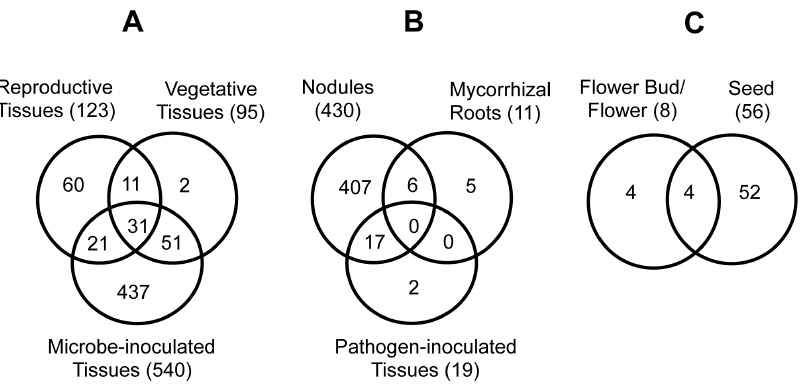
Figure 8. Venn diagrams of Medicago DEFL s expressed in different treatments. A, Comparison among all tissue types. B, Tissues inoculated with microbial symbionts and plant pathogens. C, Reproductive tissues.